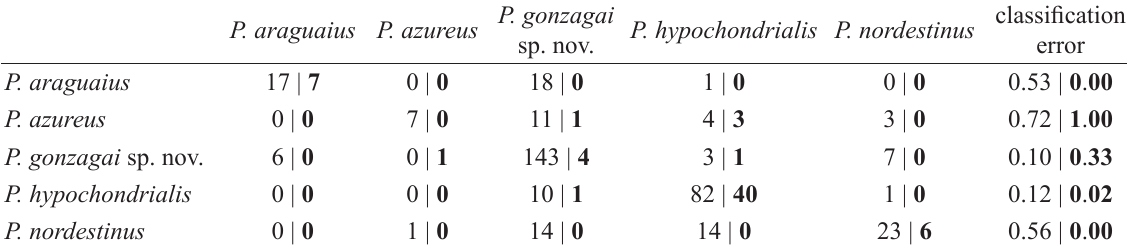
Table 4. Confusion matrix for five of the lowland species of Pithecopus Cope, 1866 based on morphometric and acoustic (values in bold) datasets by means of a randomForest model. Settings: number of tree permutations = 1000; number of variables tried at each split = 3; error rates = 25.5 % | 10 . 9 %